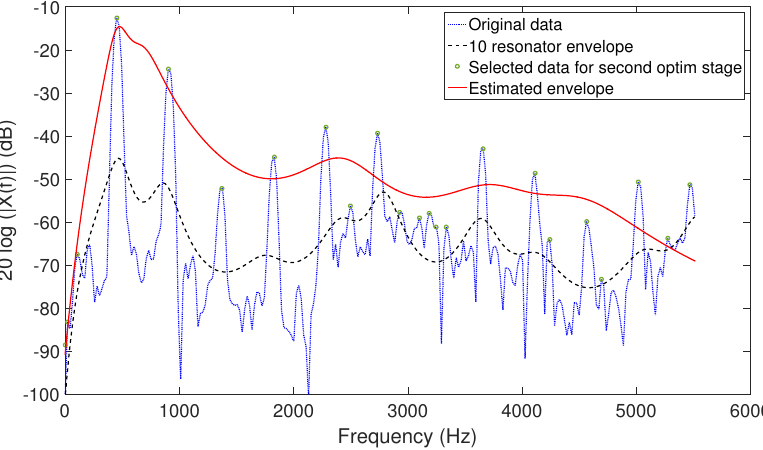
Figure 2. Estimation of the parameters of the spectral envelope. Harmonic